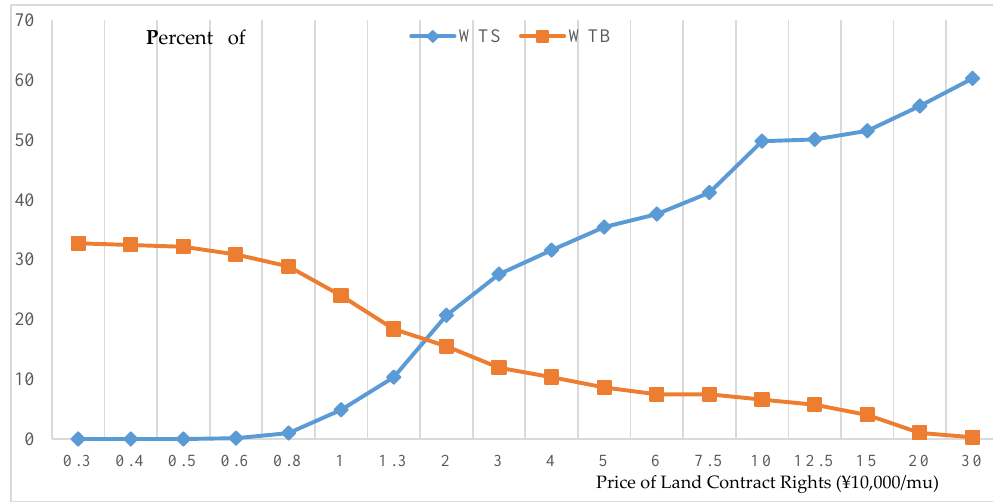
Figure 2. Potential equilibrium point of LCRs.